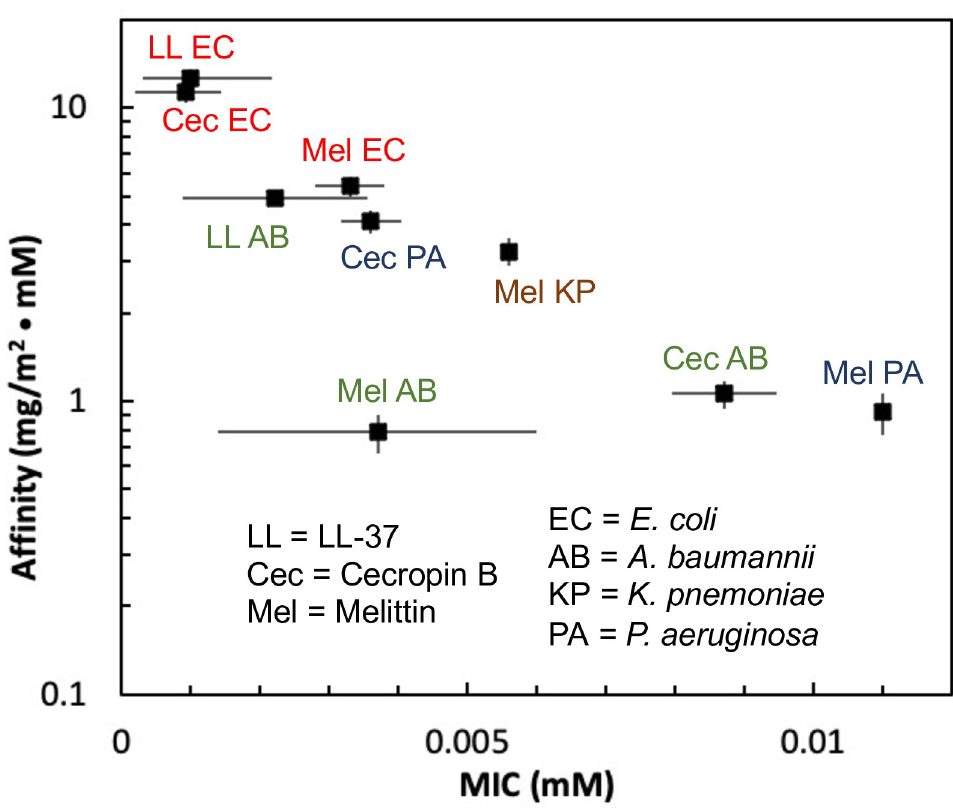
Fig 1. Semi-logarithmic plot of AMP affinity from single-molecule observations of fluorescent AMPs adsorbed on asymmetric hybrid bilayers composed of lipid a isolated from gram-negative bacteria. The data are plotted vs. the average of previously published MIC values. Table 2 summarizes the sources of the MIC values. The horizonal bars represent the full range of published values. The vertical bars represent the uncertainty in the mean affinity from replicate experiments as described in the main text. The numerical values of these data are tabulated in S1 Table in the Supporting Information.